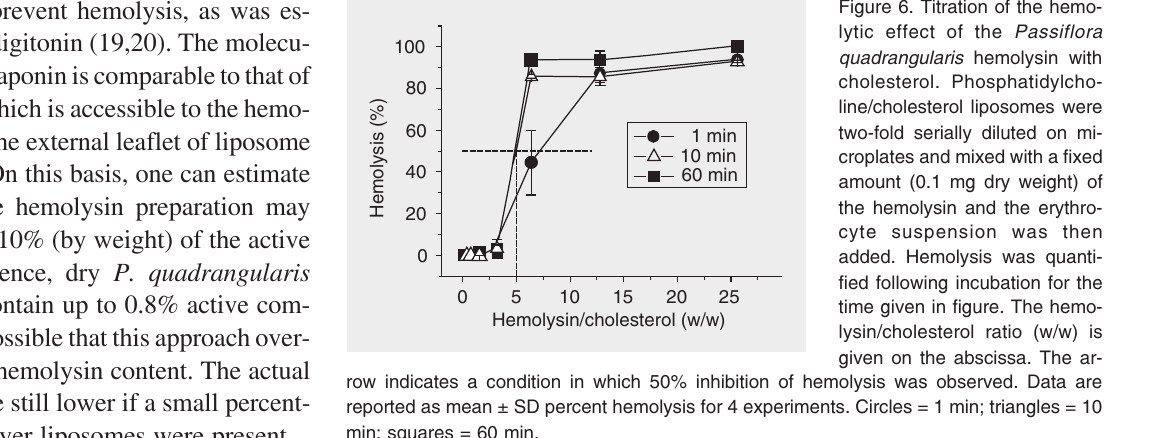
Table 1. Distribution of hemolytic activity among the fractions used for saponin extraction.